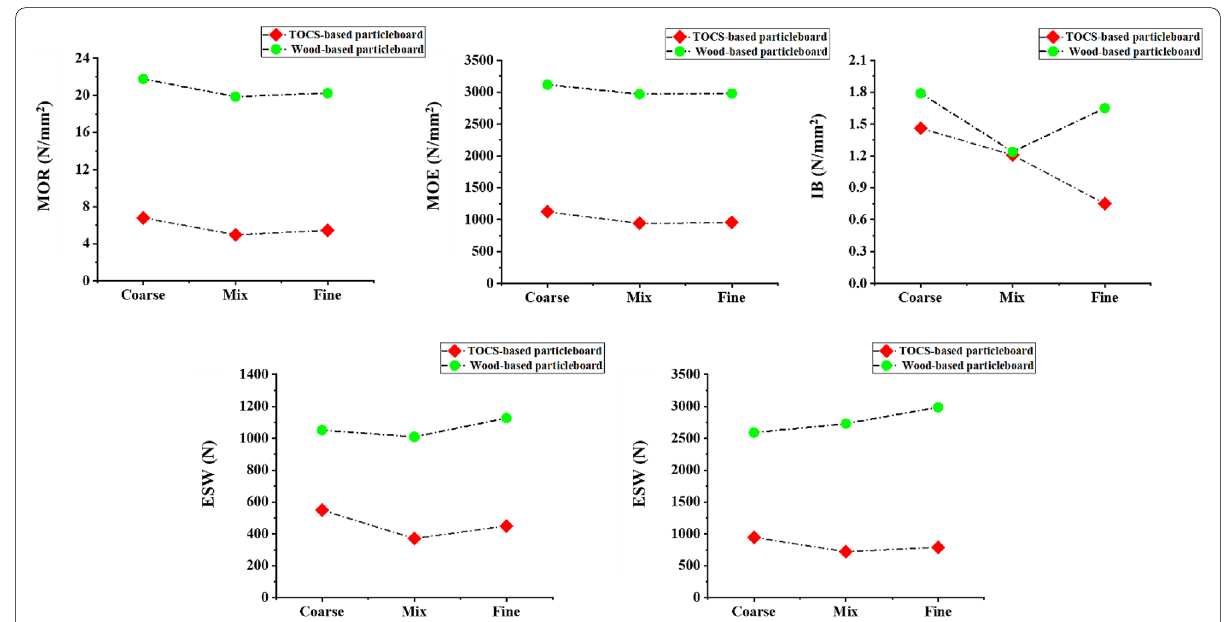
Fig. 4 Effect of particle size on mechanical properties of produced particleboards in this